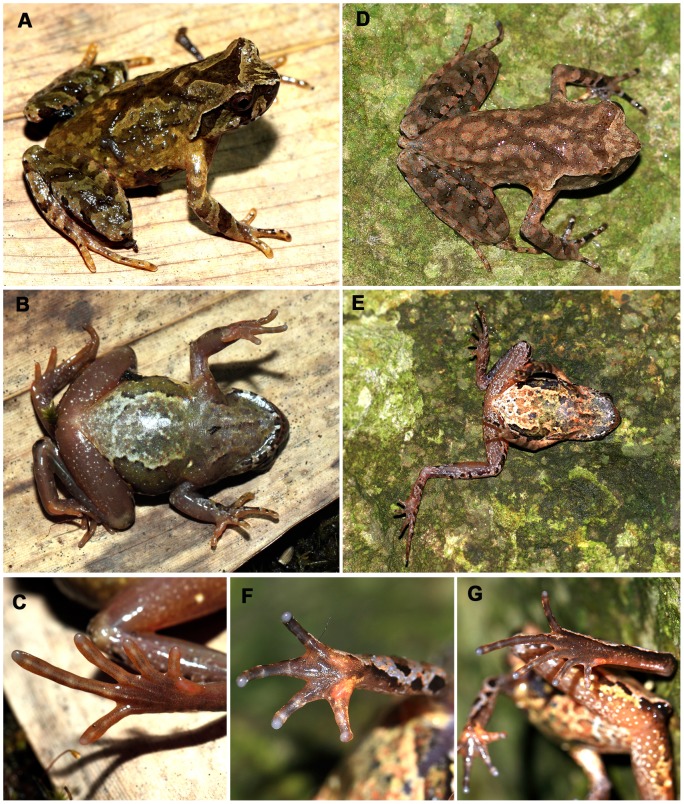

Xenophrys cheni sp. nov.A: Dorsolateral view of the live adult male Xenophrys cheni
sp. nov. holotype SYS a001873. B: Ventral view of the live holotype. C: Foot with wide lateral fringes and rudimentary webbing on the toes in the live holotype. D and E: Dorsolateral and ventral views of the live adult female paratype SYS r001429. F and G: Hand and foot of the live paratype SYS r001429. Photographed by YYW and JZ.